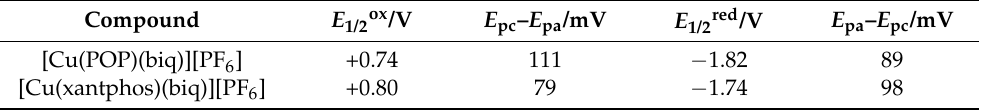
Table 3. Electrochemical processes in [Cu(POP)(biq)][PF 6 ] and [Cu(xantphos)(biq)][PF 6 ] (CH 2 Cl 2 solutions, ca. 2 × 10 − 3 mol dm − 3 ); values referenced to internal Fc/Fc + = 0.0 V. [ n Bu 4 N][PF 6 ] was the supporting electrolyte, and the scan rate was 0.1 V s − 1